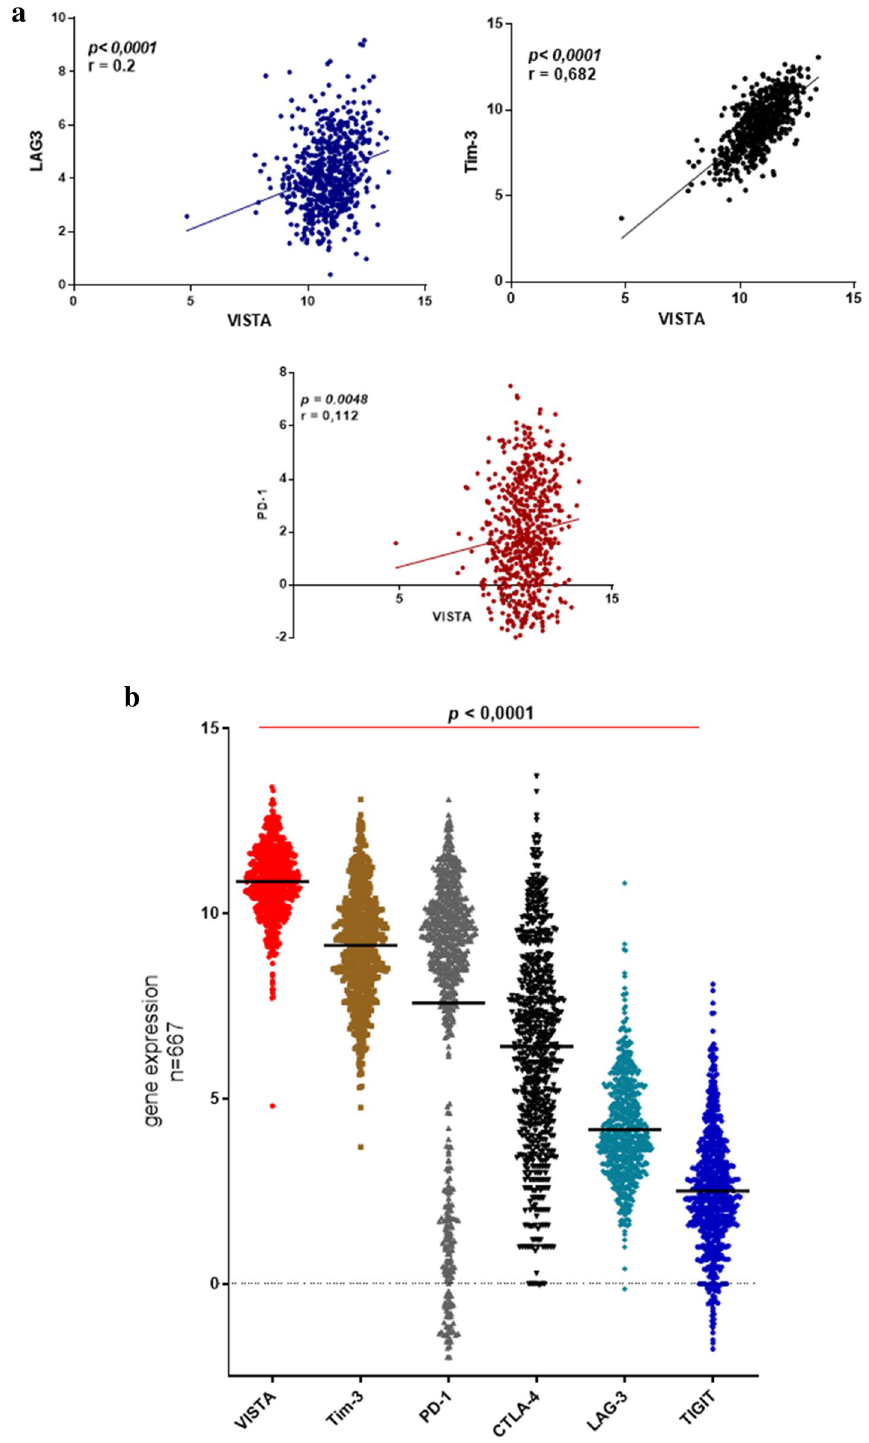
Figure 4. VISTA expression positively correlated with critical immune checkpoint regulators. ( a ) VISTA expression was positively correlated with PD-1 , Tim-3 and LAG-3 . ( b ) VISTA gene exhibited the highest expression in comparison with other immune checkpoints ( Tim-3, PD-1, CTLA-4, LAG-3, TIGIT ). Spearman correlation test was used to examine the association of relative gene expression levels between VISTA and other immune checkpoints. Also, the one-way ANOVA test was used to determine the statistical significance of gene expression among different groups of glioma patients. p value less than 0.05 was considered as statistically significant for all statistical